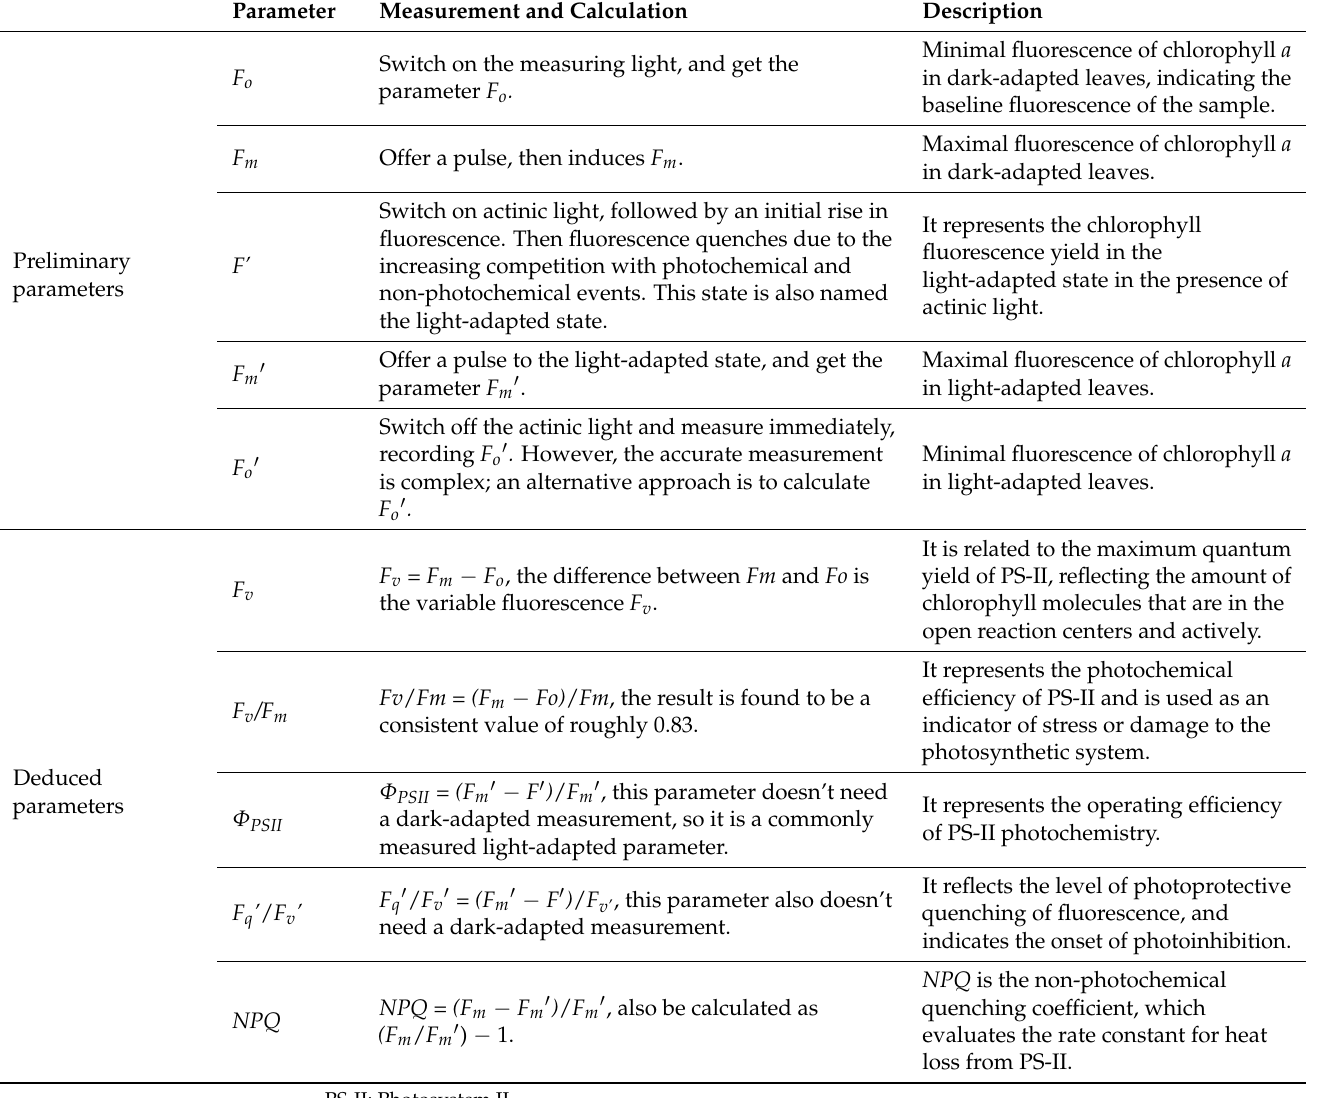
Table 1. ChlF parameters measured from the typical chlorophyll fluorescence kinetic curve. Parameter Measurement and Calculation